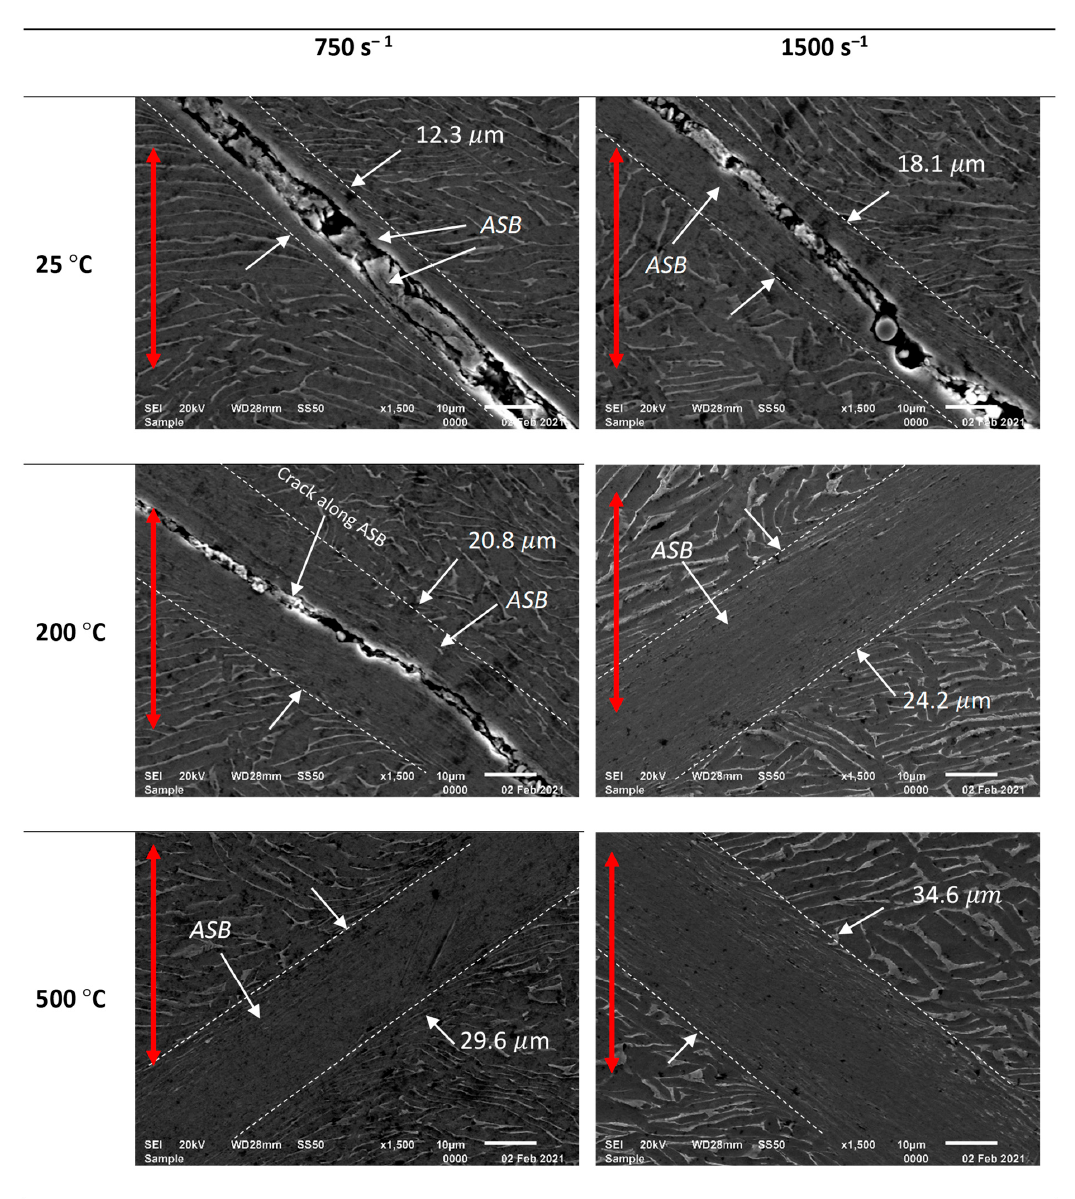
Figure 15. Secondary electron images showing adiabatic shear bands on sections of deformed surfaces of samples D at different strain rates and temperatures (the red arrows indicate the compression loading axis).